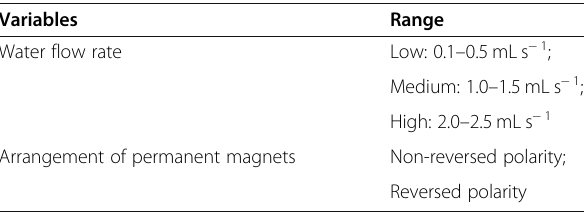
Table 1 Experimental variables for the influence of magnetic effect on water parameters Variables